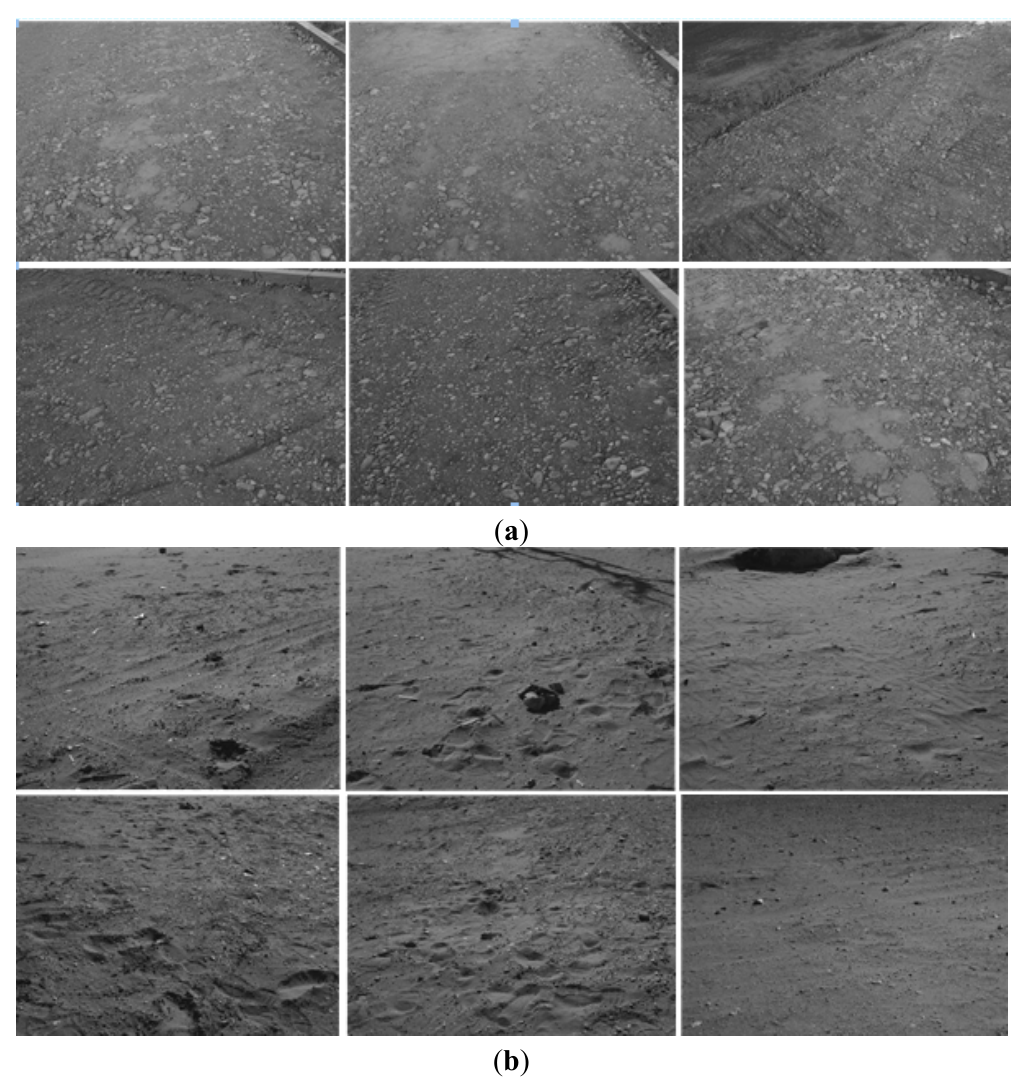
Figure 12. ( a ) Sample images from the first dataset at a construction site; ( b ) Sample images from the second dataset in a